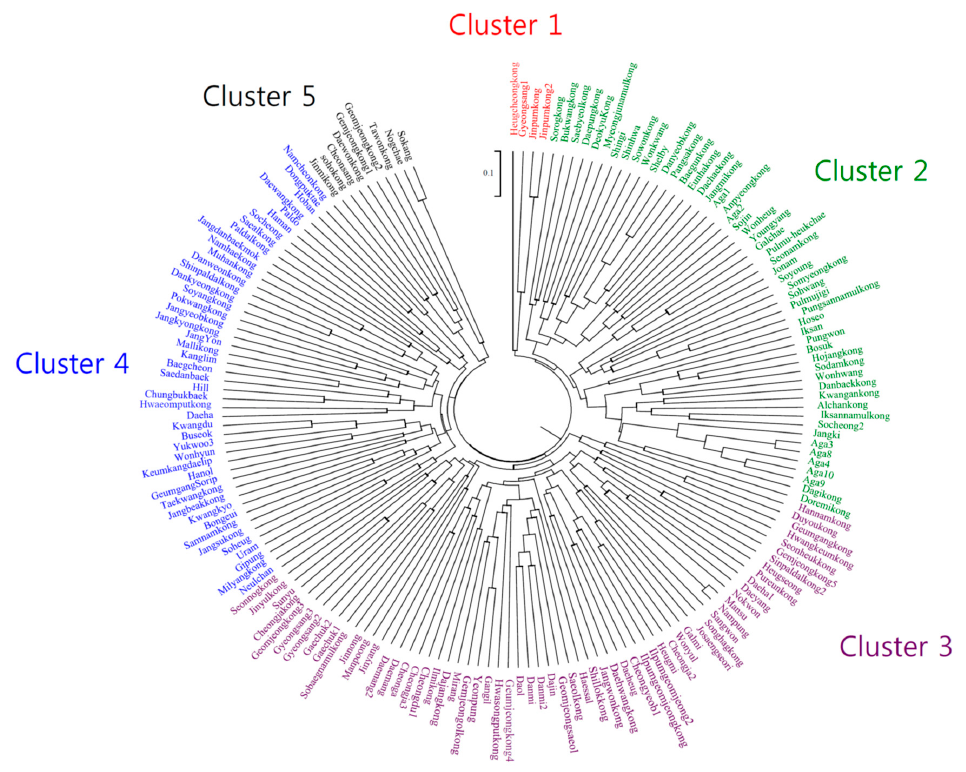
Figure 1. Unweighted pair group mean arithmetic (UPGMA) phylogenetic tree using 20 SSR markers in 172 Korean soybean varieties.